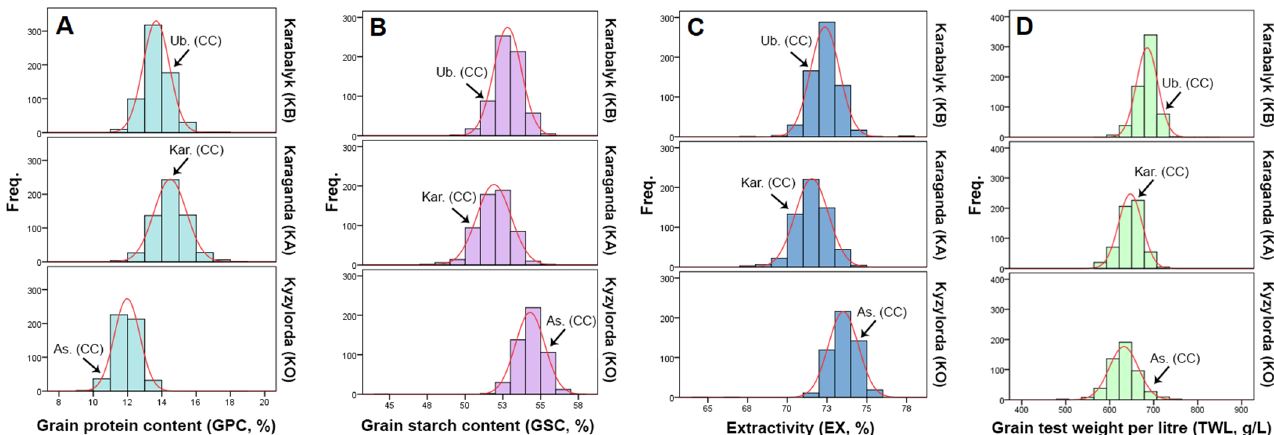
Figure 2. Average values over two years of grain quality traits of the collection harvested in three regions. ( A ) Grain protein content (GPC,%). ( B ) Grain starch content (GSC,%). ( C ) Extractivity (EX,%). ( D ) Grain test weight per liter (TWL, g/L). Freq.—frequency; CC—check cultivar; Ub.—Ub-